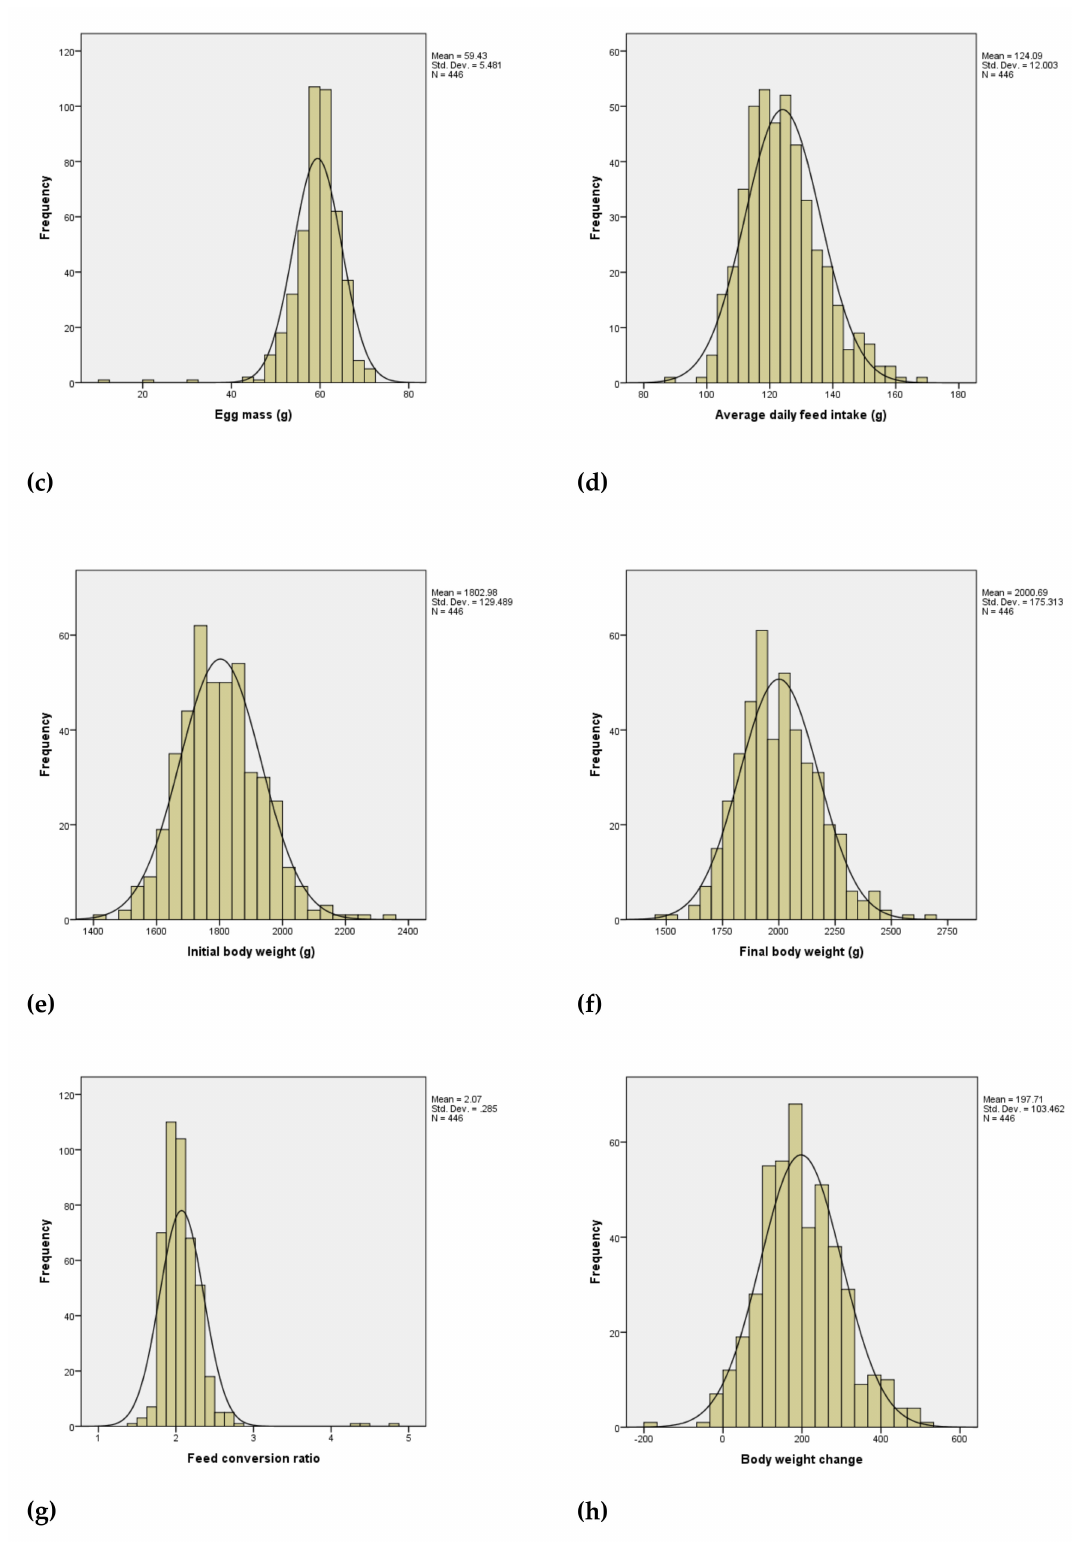
Figure 1. Histogram of performance traits showing distributions of 446 individually caged ISA Brown hens aged between 25 and 30 weeks for ( a ) egg produced per hen per day, ( b ) egg weight, ( c ) egg mass, ( d ) average daily feed intake, ( e ) initial body weight, ( f ) final body weight, ( g ) feed conversion ratio, and ( h ) body weight